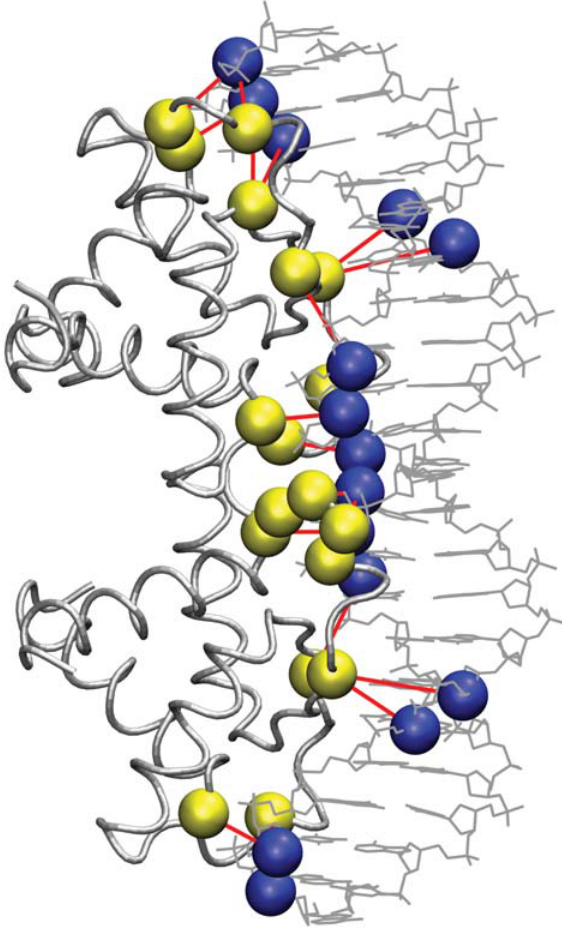
Figure 1. A bipartite graph representation of the amino acid– nucleotide interactions in a protein–DNA complex. In the bipartite graph representation of the protein–DNA complex, the amino acids and the nucleotides of the DNA form the two node sets. Shown in yellow are amino acid nodes, and blue, the nucleotides. The edges (between the nodes from one set to the other) are shown in red. These edges are defined based on a specific MEC. The MEC quantifies the minimum number of atomic contacts expected between an amino acid and a nucleotide to define an edge (Equation 1). The contacts are specifically evaluated between side chains of the amino acids and the phosphate, or the deoxyribose sugar or the base of nucleotides to form the P-p, P-S, and P-B clusters, respectively.